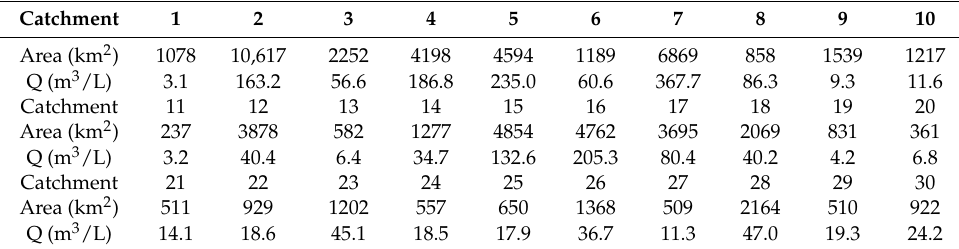
Table 3. Basin area and river mouth discharge for each